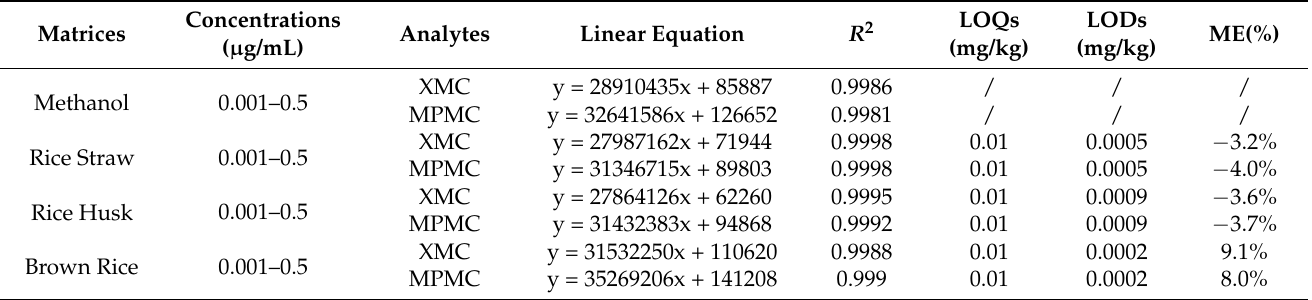
Table 1. Standard curve equation of dimethacarb.